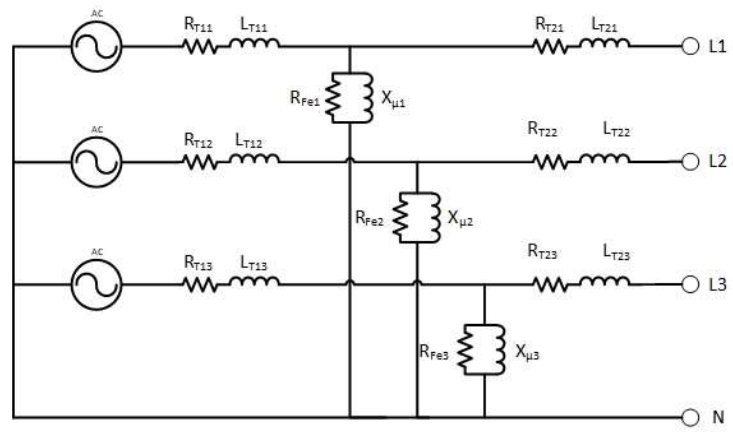
Figure 9. A medium-voltage (MV) / low-voltage (LV) transformer model.